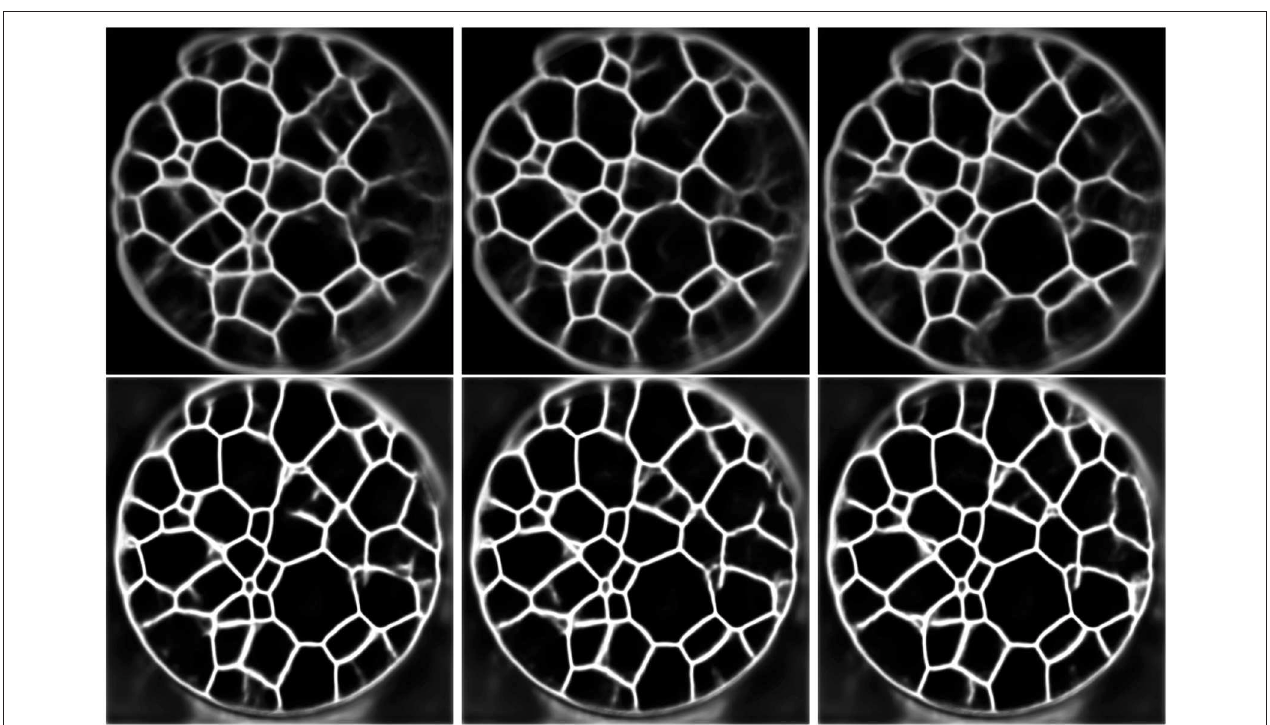
FIGURE 9 | First row: Output of the trained 2D U-Net for three different consecutive CT slices (from left to right). Second row: Output of the trained multichannel U-Net for predicting the grain boundaries of the consecutive slices considered in the first row.